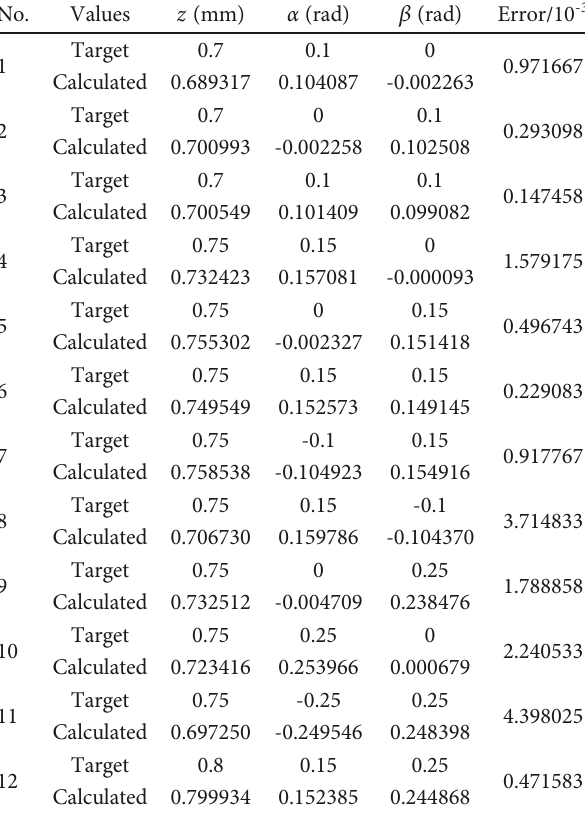
Table 2: Forward kinematics results of the parallel manipulator by utilizing the improved BP neutral